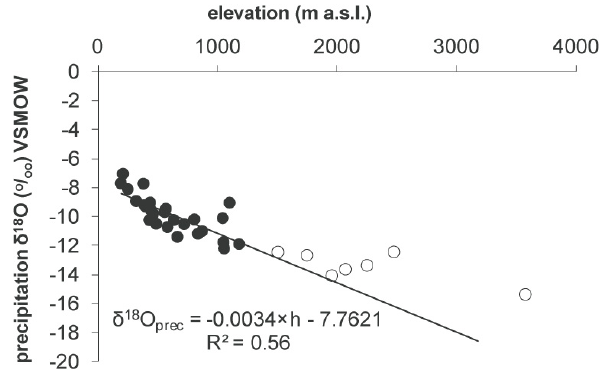
Fig. 6. Multiannual (1995–2000) amount-weighted mean stable oxygen isotope ratios from the Alpine region as a function of sta- tions’ elevation. Regression is fitted to the subset of stations below 1200ma.s.l (filled